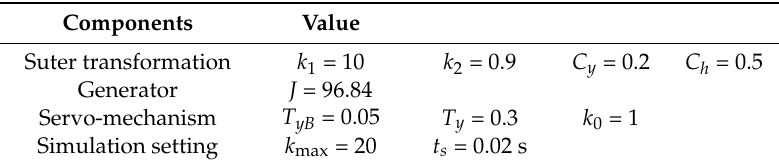
Table 5. Parameters of the simulated model of PTGS.